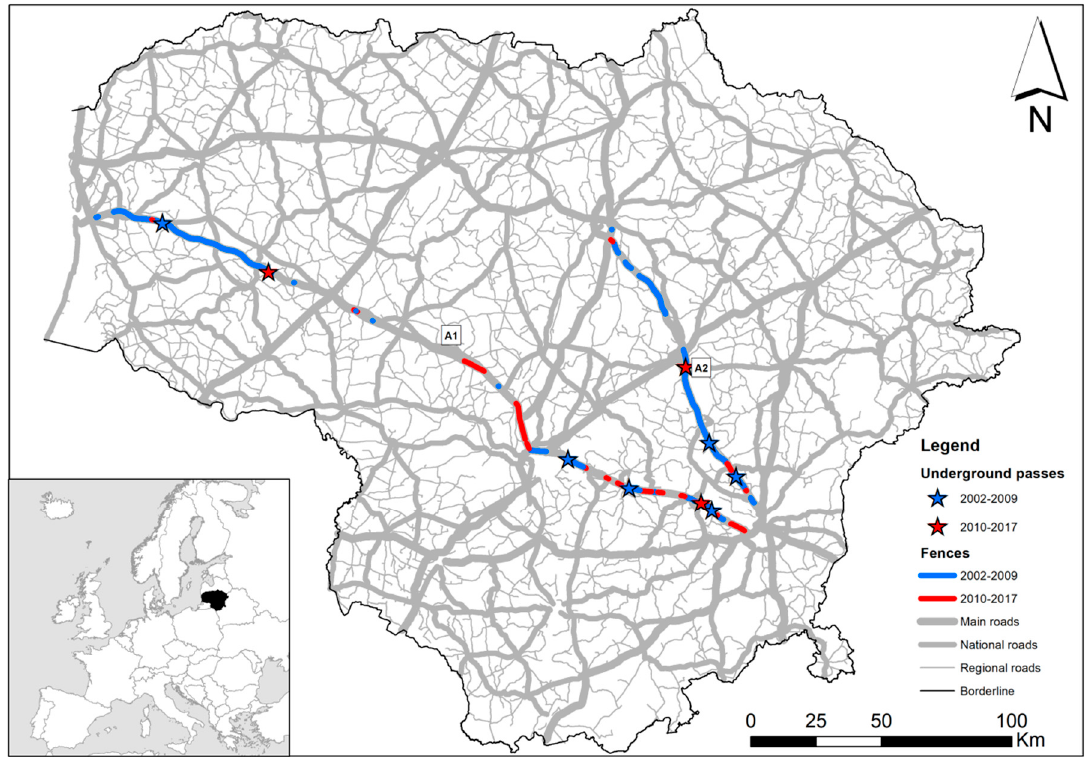
Figure 1. Study area: location of highways A1 and A2 in Lithuania. Also shown are wildlife highway fencing built in 2002–2009 (blue lines) and built in 2010–2017 (red lines), and wildlife underpasses (blue and red stars in 2002–2009 and 2010–2017, respectively).